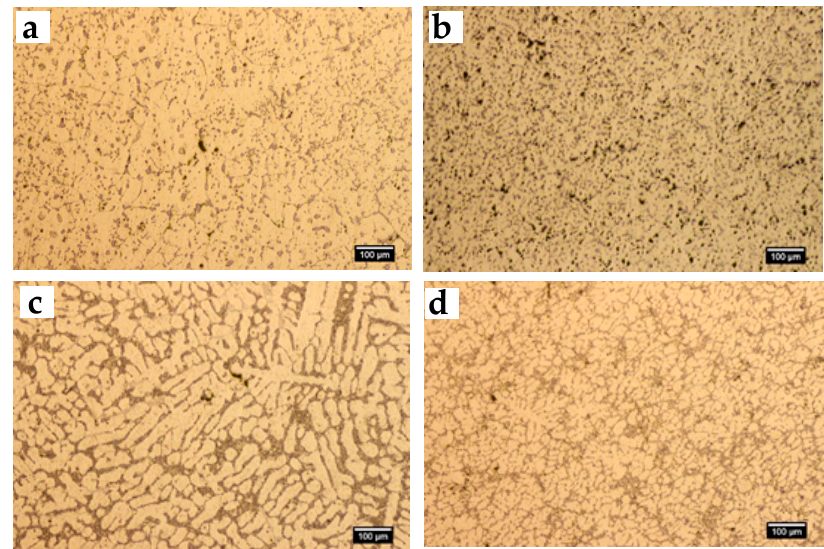
Figure 5. ( a ) The optical microscopy results of the A356 aluminum matrix nanocomposites rein- forced by different weight fractions of silica nanoparticles, i.e., ( a ) 0.0, ( b ) 2.0, ( c ) 4.0, and ( d ) 6.0 gr reinforcing materials.